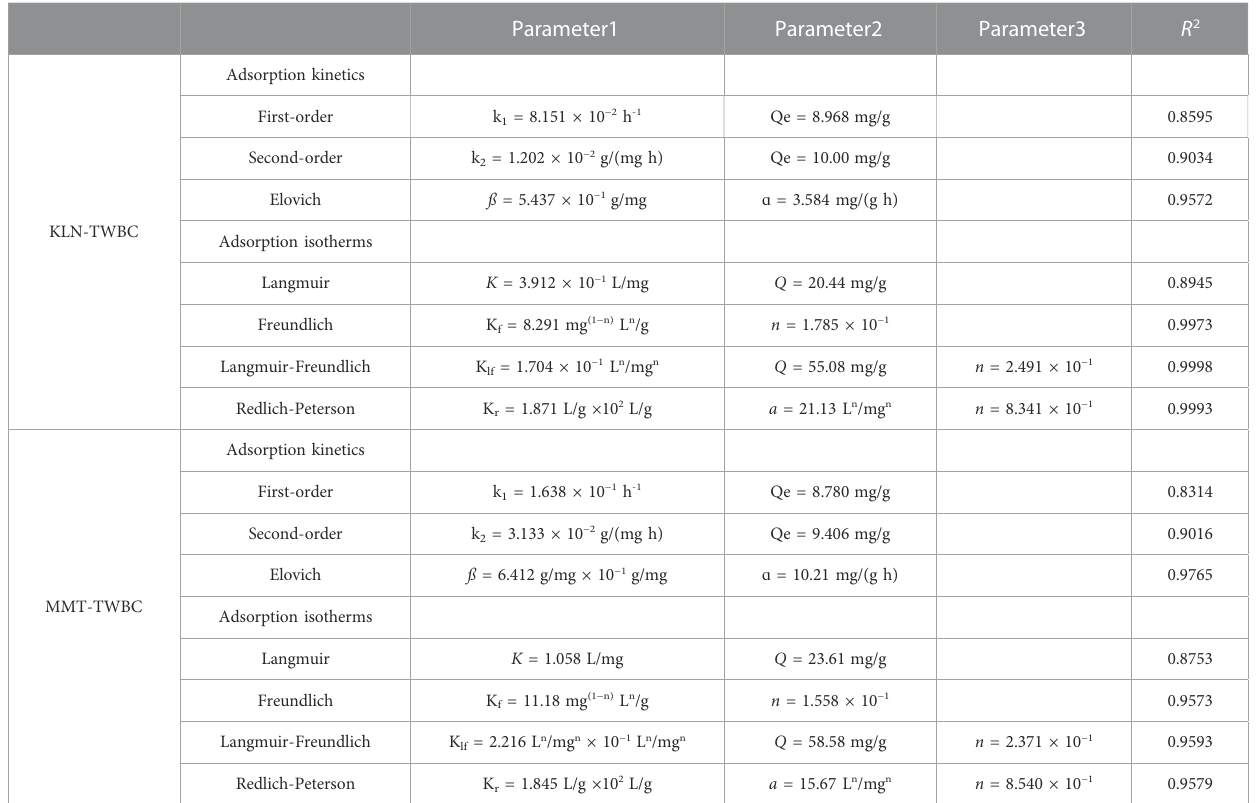
TABLE 2 Best- fi t models parameter of MB adsorption kinetics and isotherms. Parameter1 Parameter2